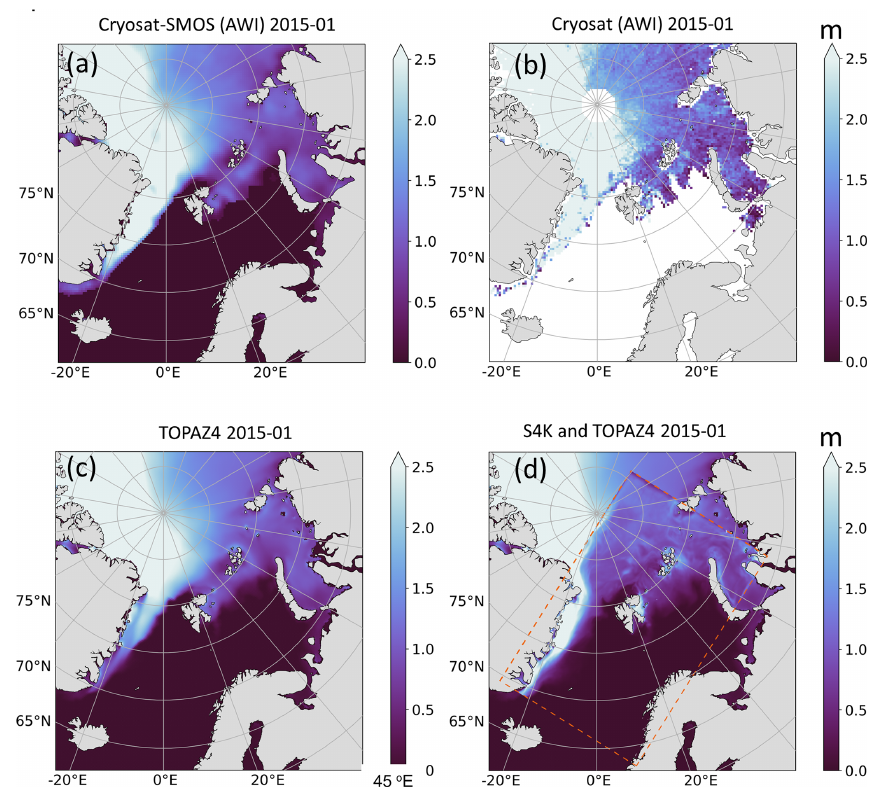
Figure 9. CryoSat2-SMOS (a) , CryoSat-2 (b) , TOPAZ4 (c) and S4K (d) monthly mean sea ice and snow thickness for January 2015. S4K fields are inserted in the TOPAZ4 model domain in the rectangle defined by the dashed line included in panel (d) (see